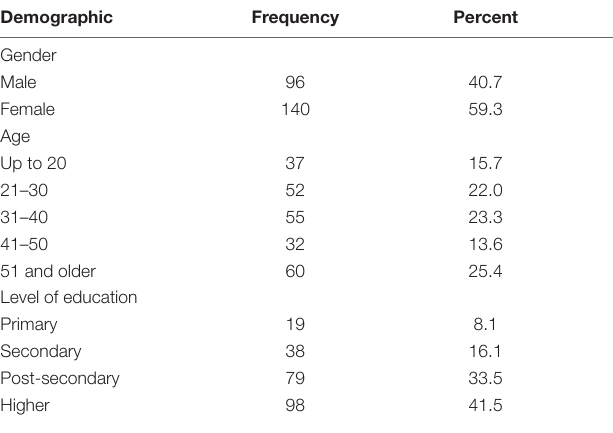
TABLE 1 | Sample distribution of respondents’